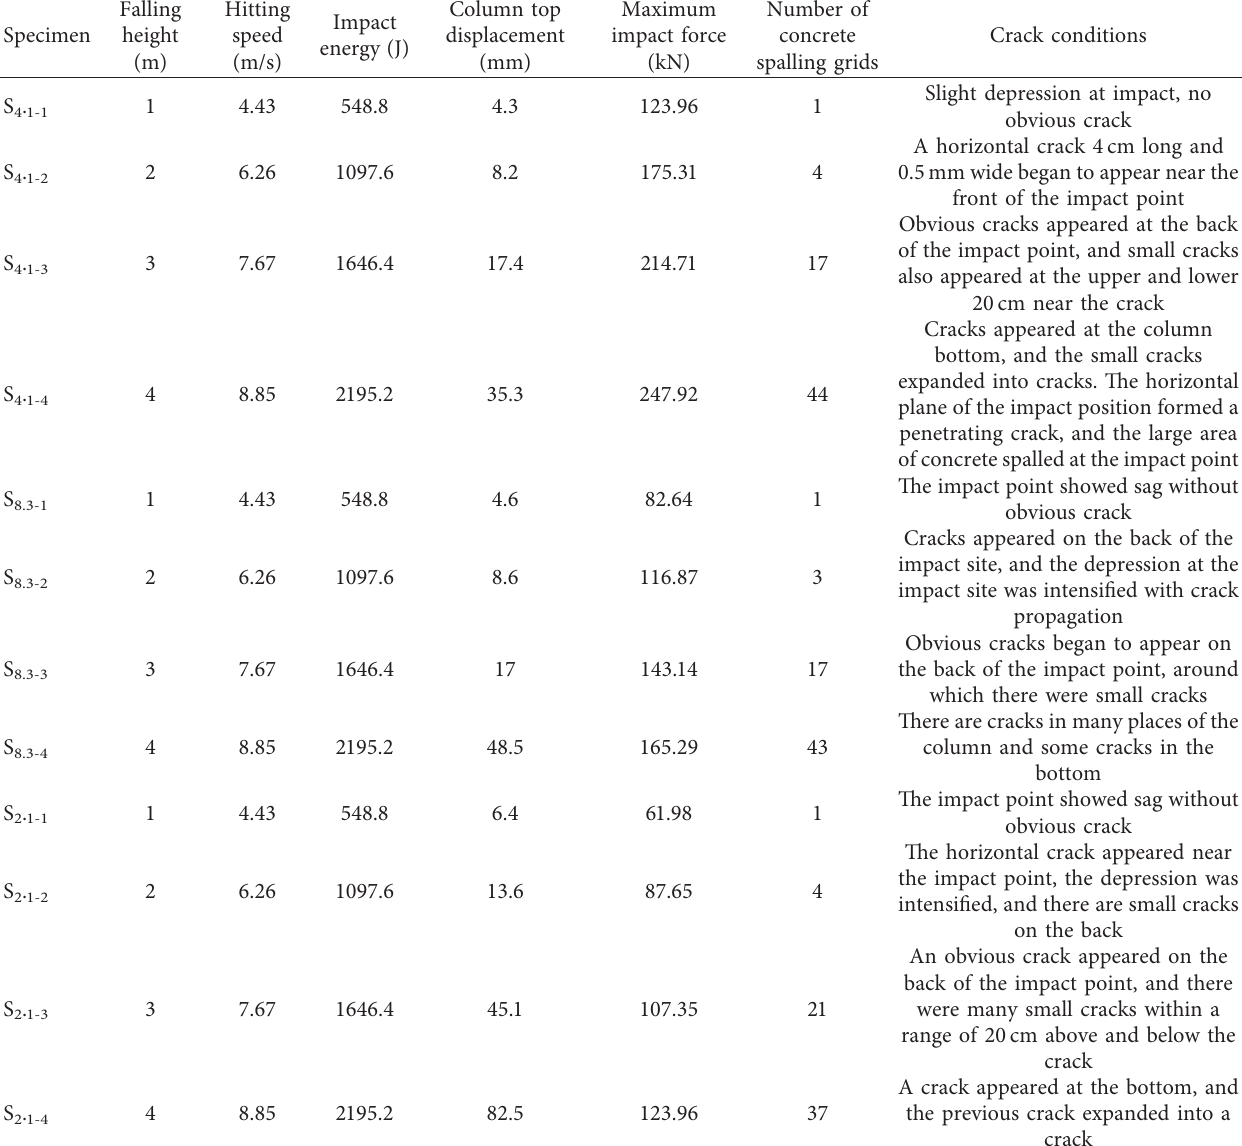
Table 4: Peak values and crack